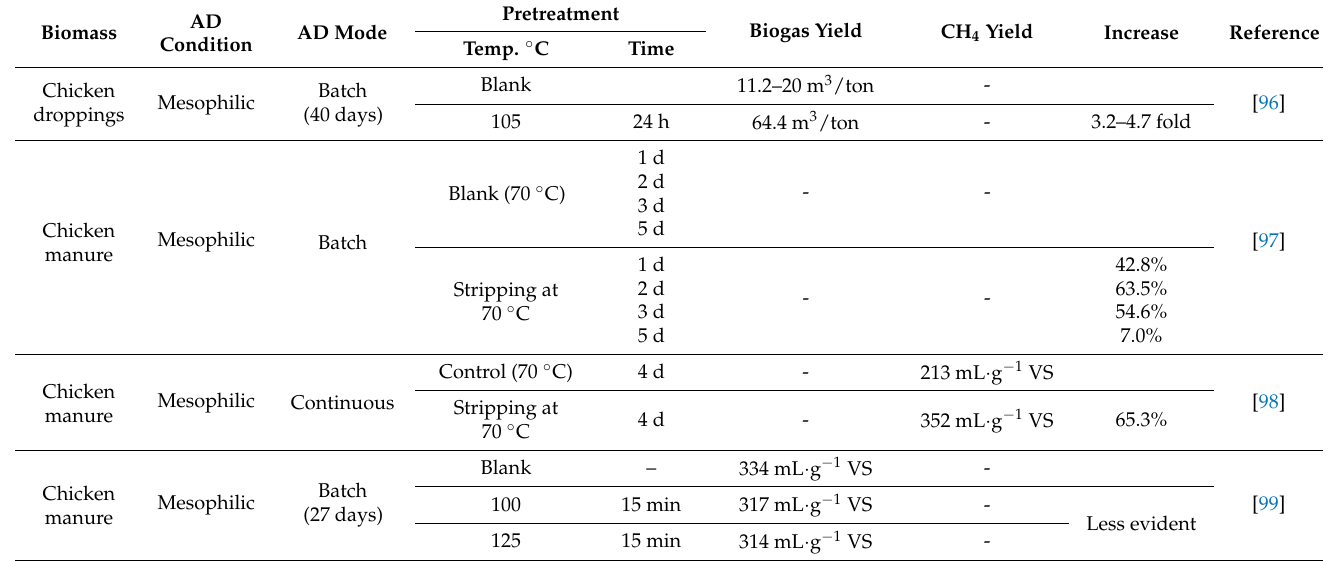
Table 4. Biogas production variation of chicken manure after LTPT (Temp. ≤